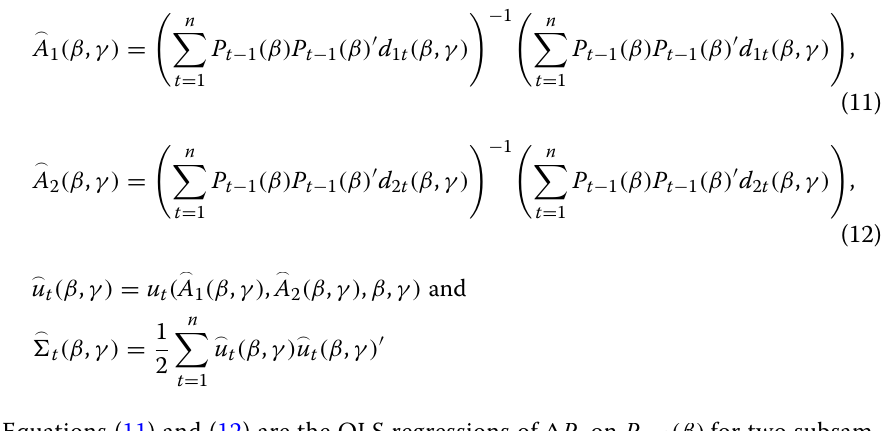
Equations (11) and (12) are the OLS regressions of (cid:31) P t on P t − 1 (β) for two subsam- ples where w t − 1 (β) ≤ γ and w t − 1 (β) ≻ γ . In the next step, the estimates (